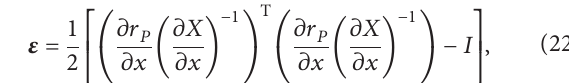
Figure 3: Kinematic description of the rigid